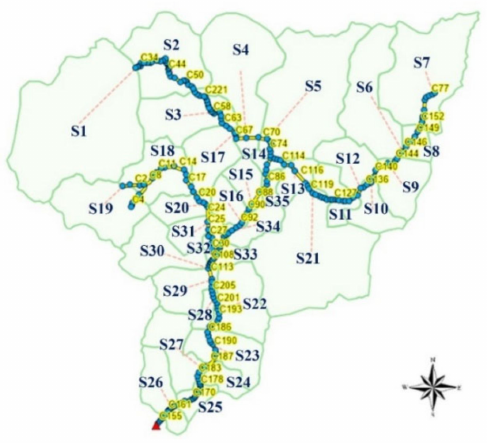
Figure A2. The streamflow data observed at the TTDI Jaya gauging station (No. 3015490) was used to check the water level estimated by the model.